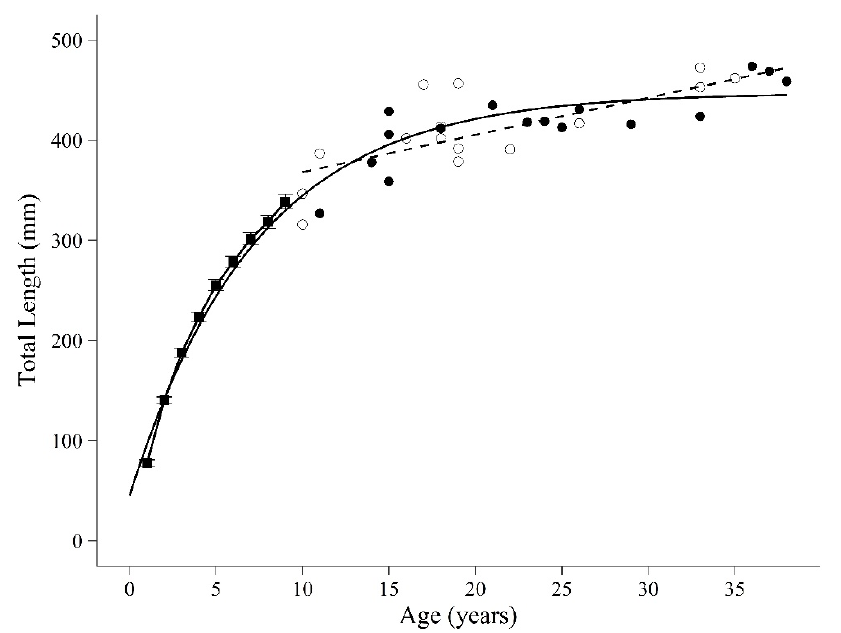
Figure 3. Two-part representation of growth curve for S. maliger captured in southeast Alaska USA, in 2016. The first nine years of growth are represented by mean total length ( ± 1 standard error) for ages 1–9 (solid squares) obtained through back-calculations of growth increments of otolith annuli. Means are connected by a solid line representing the early growth trajectory. The second part of the growth curve represents growth from age 10+ as indicated by size at age captured. Females are represented by open circles, males are represented by closed circles, and the dotted line represents the best fit regression line. The von Bertalanffy growth function is indicated by the solid line that extends across all ages.